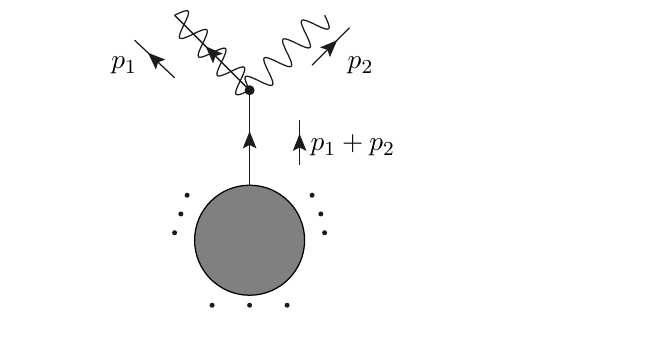
Figure 16 . Feynman diagrams leading to collinear gravitino and gauge boson